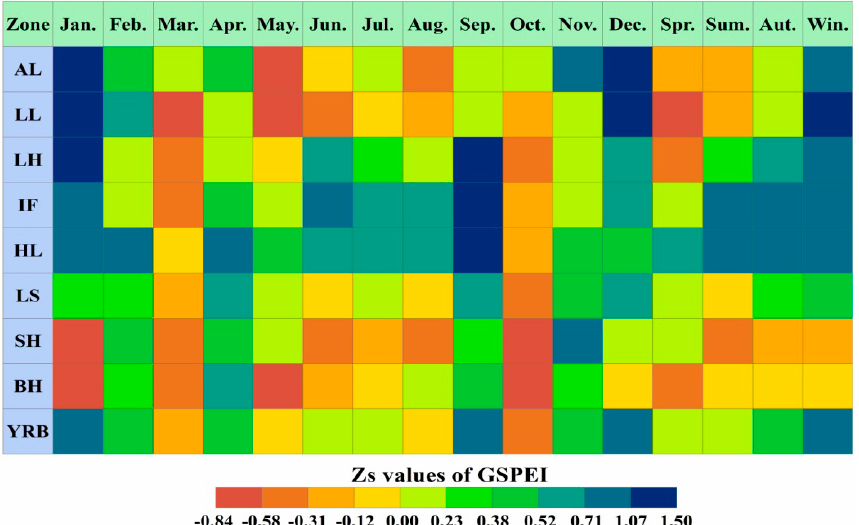
Figure 9. Z s values of monthly and seasonal Gridded Standardized Precipitation Evapotranspiration Index (GSPEI) in the Yellow River basin (YRB) during 1998–2016.